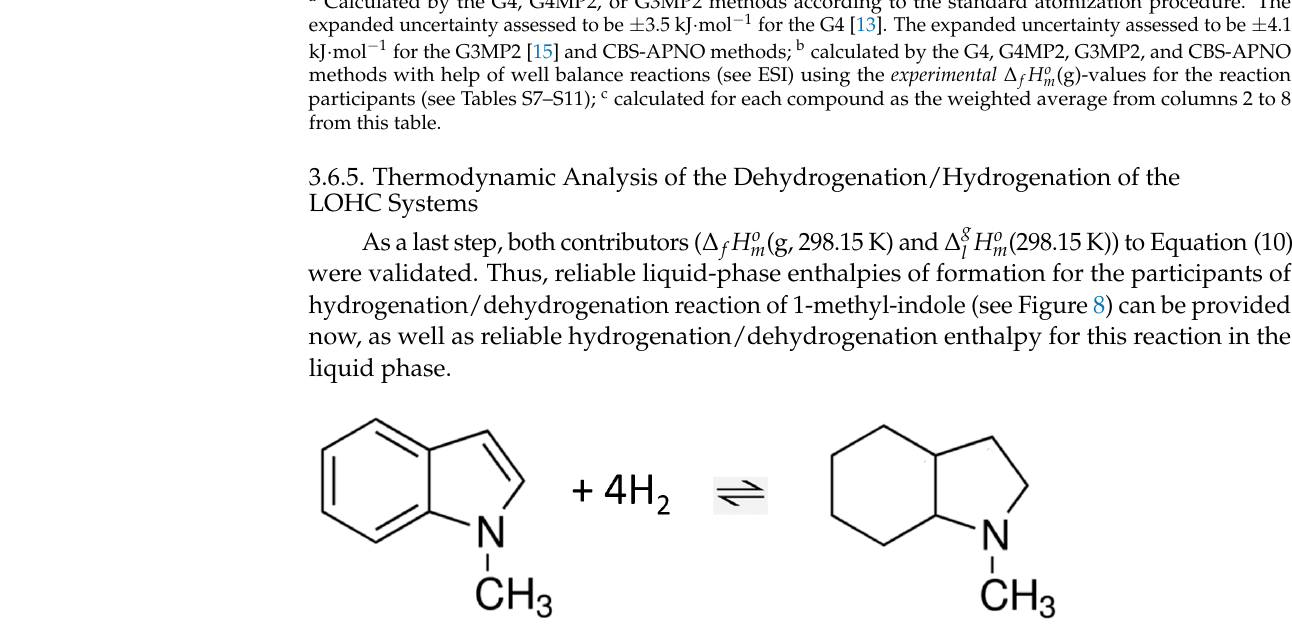
Figure 8. Hydrogenation/dehydrogenation reaction of 1-methyl-indole in the liquid phase. Thermochemical data required for these calculations are given in Table 7 for the hydrogen-rich (HR) species. Table 7. Liquid phase enthalpies of formation, ∆ f H o m (liq), of the hydrogen-reach counter-parts, Table 7. Liquid phase enthalpies of formation, ∆ (cid:2916) 𝐻 mo (liq), of the hydrogen-reach counter-parts, at T